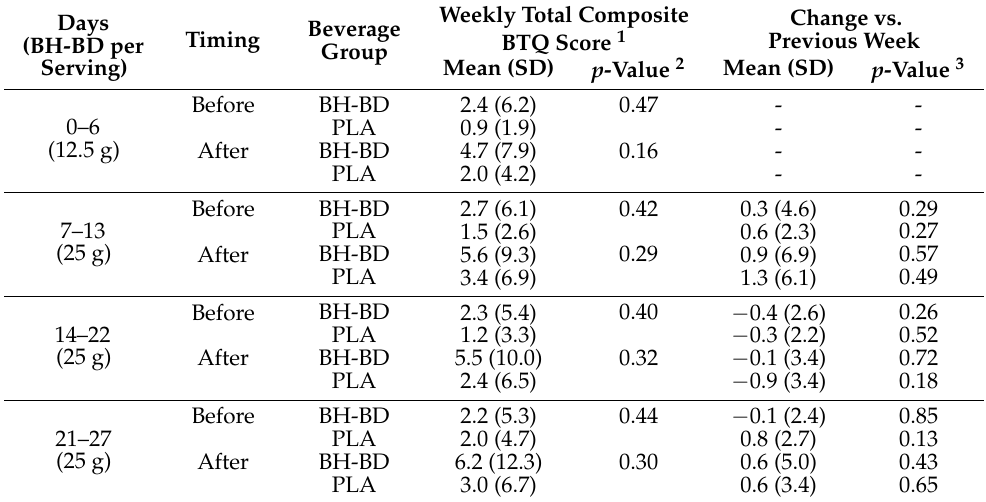
Table 3. Weekly total composite BTQ scores for healthy participants either before or 3–6 h after consuming BH-BD or placebo at home.